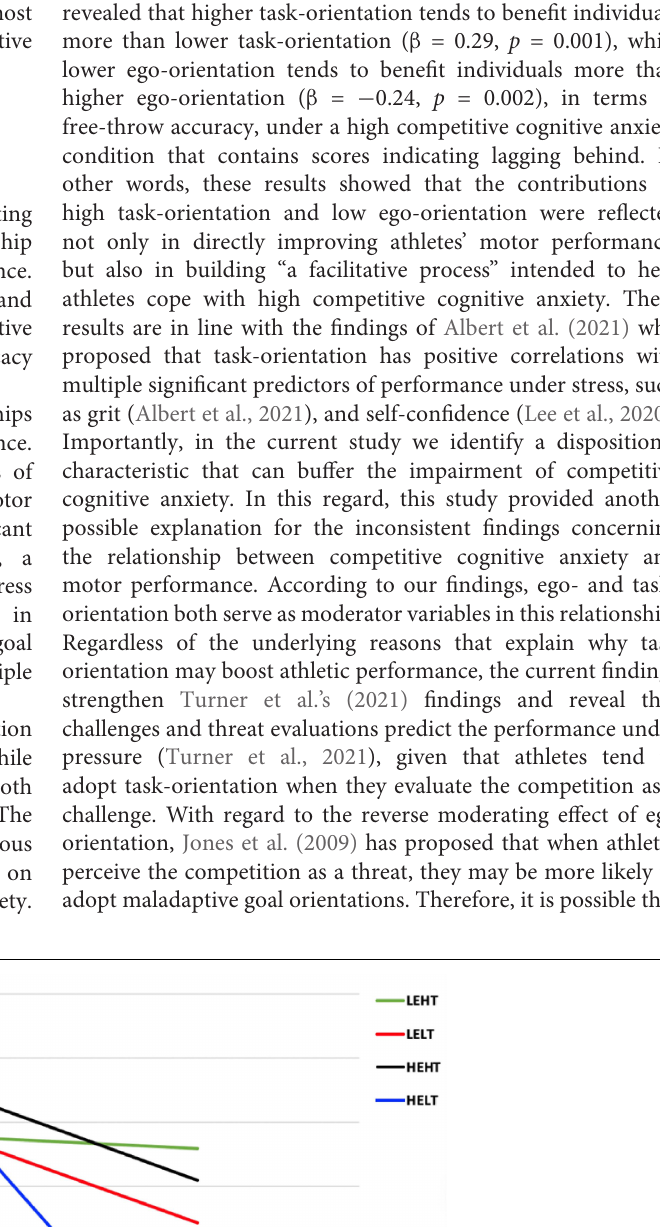
Frontiers in Psychology |